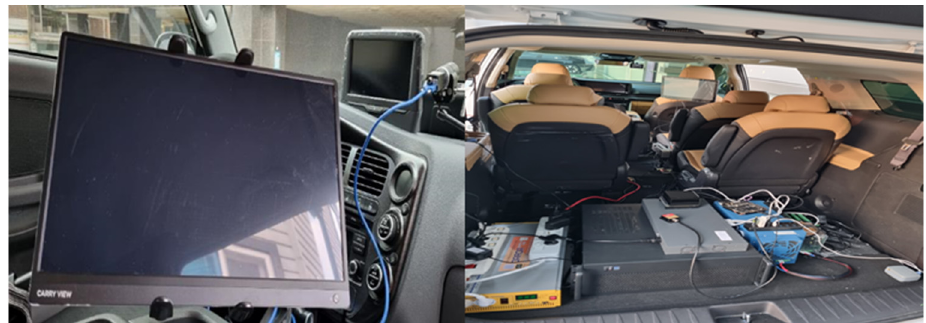
Figure 2. Overview of the installed system in a driving car.